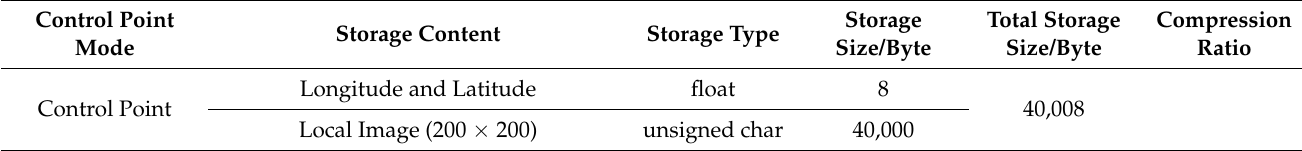
Table 2. Comparison of single control point storage and single feature points extracted by different feature extraction